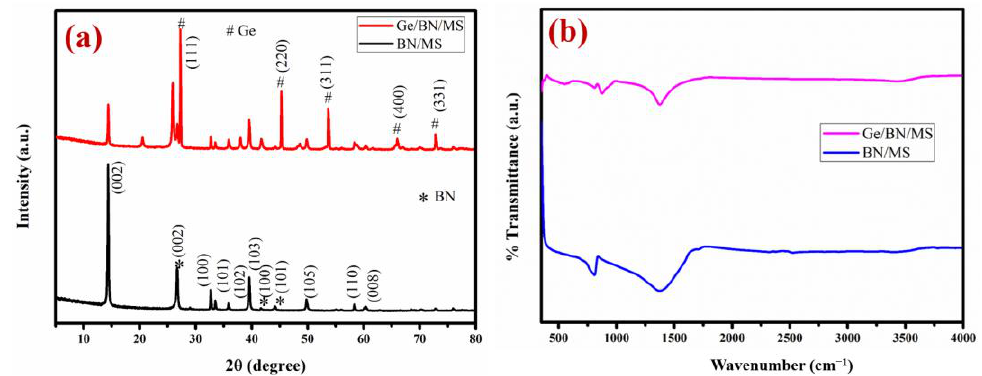
Figure 2. ( a ) XRD, ( b ) IR spectra of h-BN/MoS 2 and Ge-modulated h-BN/MoS 2 . The two peaks at 1369 cm −1 and 870 cm −1 for h-BN/MoS 2 are allocated to the boron- nitrogen-boron (B-N-B) bending mode and the boron-nitrogen (B-N) in-plane stretching mode, respectively, while the hydroxyl groups that are adsorbed on the MoS 2 nanosheets are assigned to 3439 cm −1 and 1692 cm −1 . The bending mode is attributed to the positively charged hydroxyl present on the MoS 2 [24,25]. The creation of a Ge-N bond is evident in the absorption bands at 791 cm −1 , clearly confirming the interaction between h-BN/MoS 2 and Ge. From the above FTIR results, it can be said that Ge-, h-BN-, and MoS 2 -based nano- composites have been achieved. XPS survey spectral analysis was carried out to confirm the presence of boron (B), nitrogen (N), molybdenum (Mo), sulphur (S), and germanium (Ge) elements in the ob- tained Ge/h-BN/MoS 2 , as shown in Figure 3. To understand the bonding pattern, high-resolution spectra of each individual ele- ment were examined. XPS spectra of the boron core-level emission (B 1s) and nitrogen core-level emission (N 1s) (Figure 3a,b) revealed the network of B-N bonding in h-BN, which were centred at binding energies (BEs) of 188.89 and 397.2 eV, respectively. The molybdenum (Mo 3d) core-level emission spectra corresponding to h-BN/MoS 2 result in well-resolved peaks at BEs of 230.9 and 234.4 eV, indicating spin-orbit components Mo 3d3/2 and Mo 3d3/2, respectively, in Figure 3c [26]. The S 2p spectra (Figure 3d) of MoS 2 nanosheets in the S 2− oxidation state exhibit a peak at 162.4 eV and broaden toward higher BEs. Because each MoS 2 sheet has a low grafting density and a restricted number of lamel- lae, the S 2p spectra produced a weak signal that could not be resolved in S 2p2/3 and 2p1/2 orbits-based peaks [27,28]. Ge 3d exhibits a large peak below 31.8 eV in its XPS spec- tra (Figure 3e), which can be attributed to Ge.